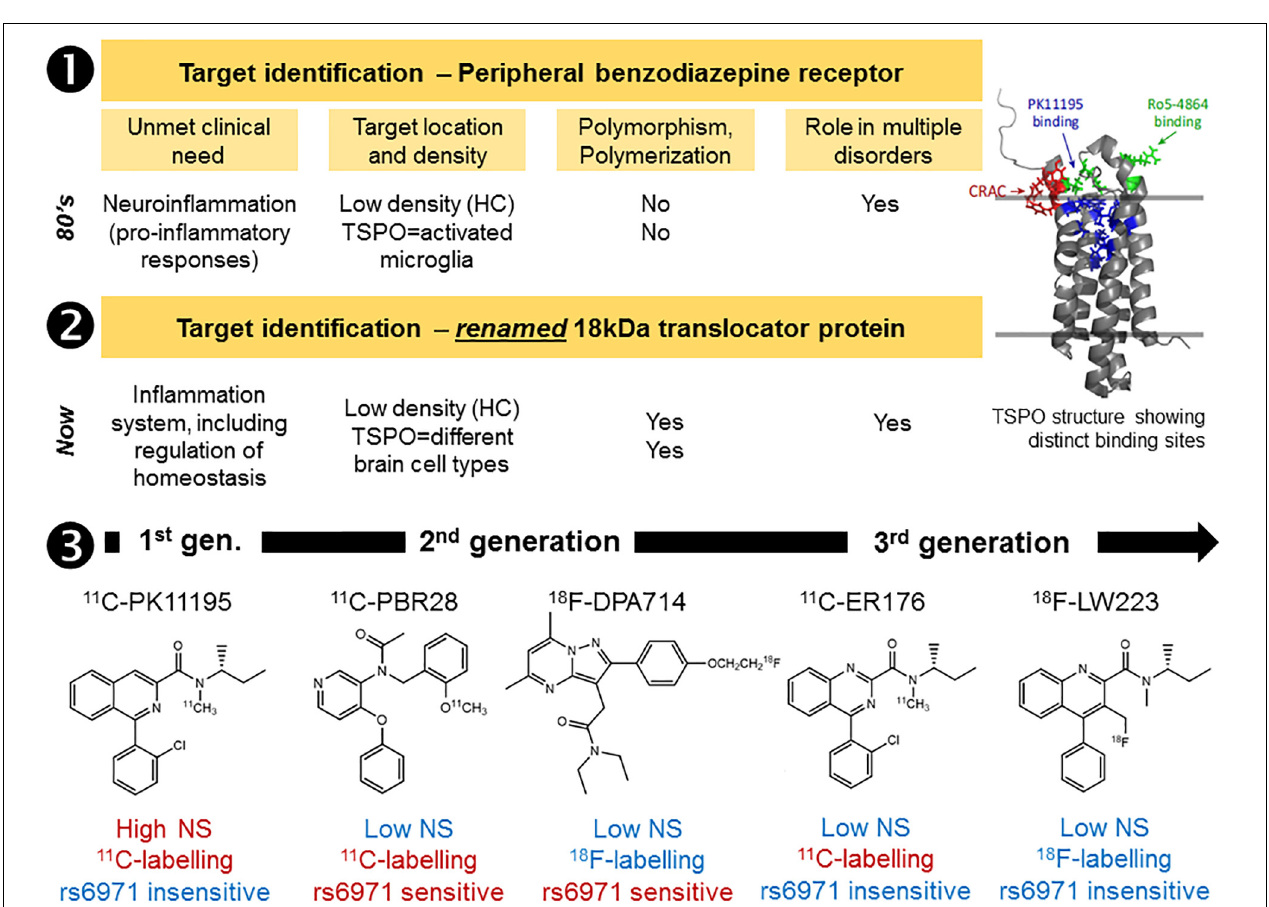
FIGURE 2 | Case study 1: Imaging the 18kDa translocator protein (TSPO), a “moving target” over the past three decades. The development of novel TSPO radiotracers suffered from high degree of attrition over the years (1–3). First there was the renaming of the target, in recognition of the wider functions of this protein. Then the identification of a genetic polymorphism (rs6971) capable of impacting on radiotracer binding in humans (2nd generation, 2nd gen., radiotracers). Alongside these discoveries came the recognition that TSPO has at least three binding sites and can be expressed in a monomer or a polymer configuration depending on the organ or disease process under investigation. Furthermore, limited characterization of the TSPO expression in various cell types decades ago has created a delayed realization that TSPO PET/SPECT imaging was always directed toward understanding TSPO molecular changes rather than cell changes. All these serendipitous findings at the first stage of the radiotracer development pipeline (target identification) have impacted on the development of novel and successful TSPO radiotracers (1 and 2). Despite these difficulties, through a series of compound libraries from 1st generation (1st gen.) radiotracers, like 11 C-PK11195, to 3rd generation (3rd gen.) radiotracers like 11 C-ER176 and 18 F-LW223, it was possible to resolve the target identification issue, while improving radiotracer properties, such as reduction of non-specific binding (NS) and convenient labeling with fluorine-18 (3). Red and blue text indicates limitations and advantages of each example radiotracer displayed in row 3. HC, healthy control brain. TSPO structure taken from Selvaraj and Stocco, Trends in Endocrinology and Metabolism, 2015,